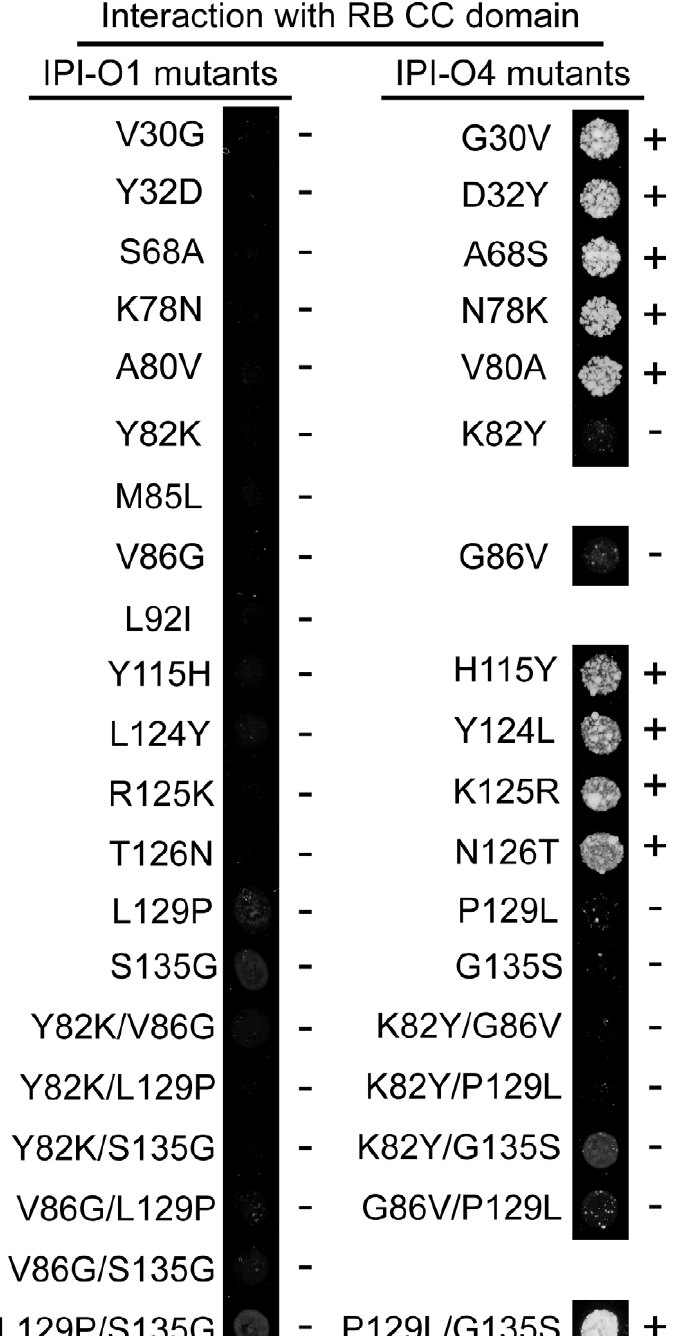
Figure 3. Yeast two-hybrid interactions between the CC domain of RB and IPI-O1/4 single and double amino acid mutants. + and 2 signs to the right of the yeast colonies indicate positive or negative interaction, respectively. Pictures were taken after 8 days of growth on selective media. All the experiments were performed three times.